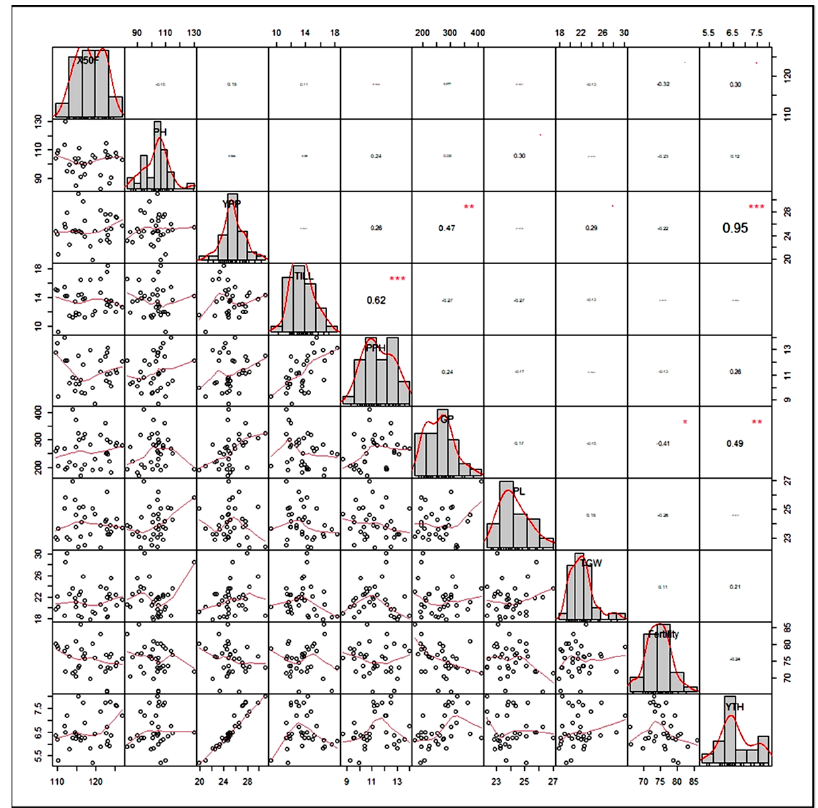
Figure 1. Correlation coefficient matrix, scatter plot, and phenotypic frequency distribution among grain yield and yield-related traits over the locations. Each variable’s distribution is displayed diagonally. The bivariate scatter plots with a trend line are shown at the bottom of the diagonal. The correlation coefficient and the level of significance are displayed as stars at the top of the diagonal. * p ≤ 0.05, ** p ≤ 0.01, and *** p > 0.001 show significance level; Note: X50F = days to 50% flowering, PH = plant height (cm), TILL = number of tillers per hill, PPH = number of panicles per hill, PL = panicle length (cm), GP = grains per panicle, Fertility = fertility (%), YPP = grain yield per plant (gm), TGW = thousand grain weight (gm), and YTH = grain yield